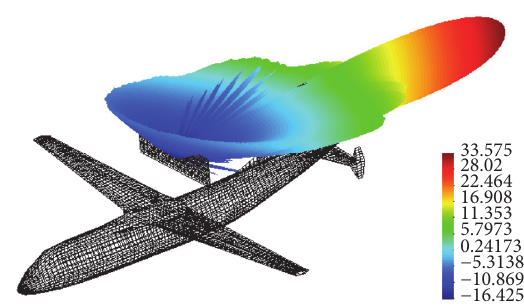
Figure 19: 3D results of the airborne wire antenna array.